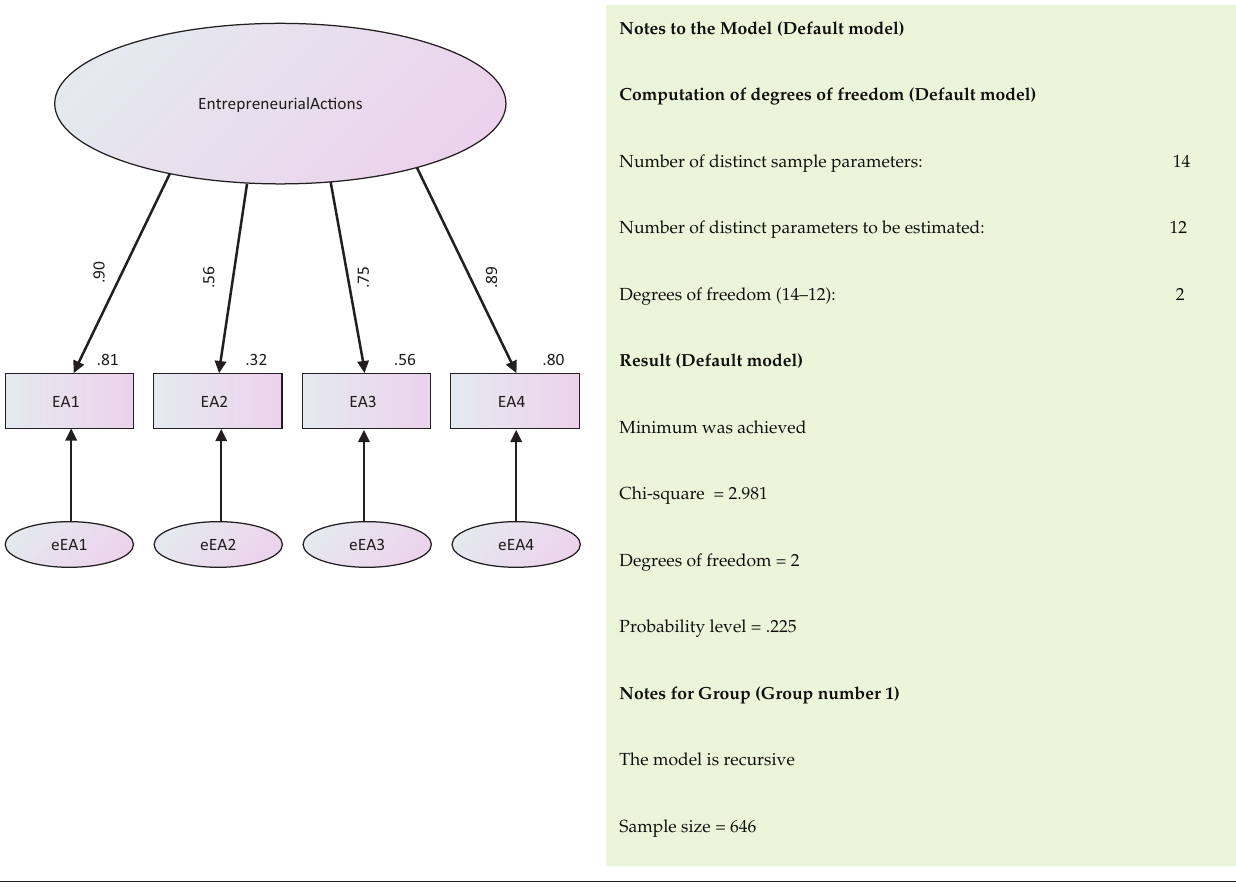
FIGURE 3: Confirmatory Factor Analysis model for entrepreneurial